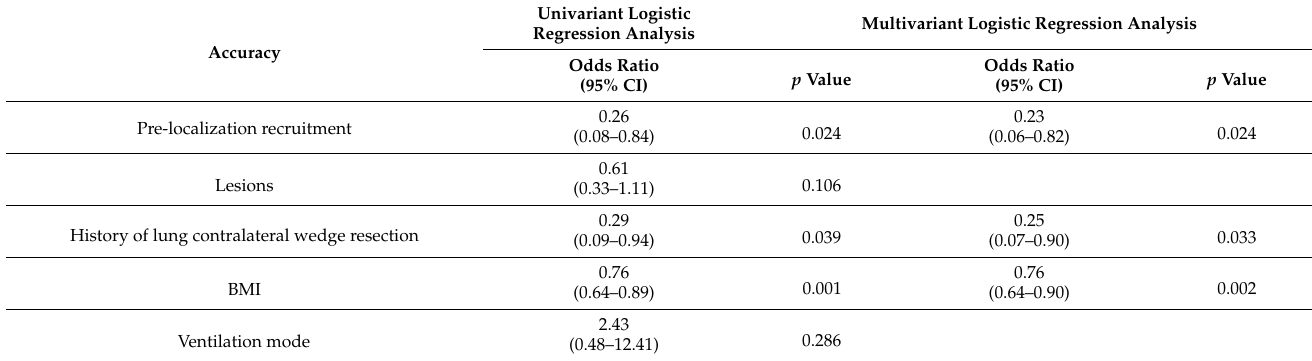
Table 3. Predictors of localization accuracy.